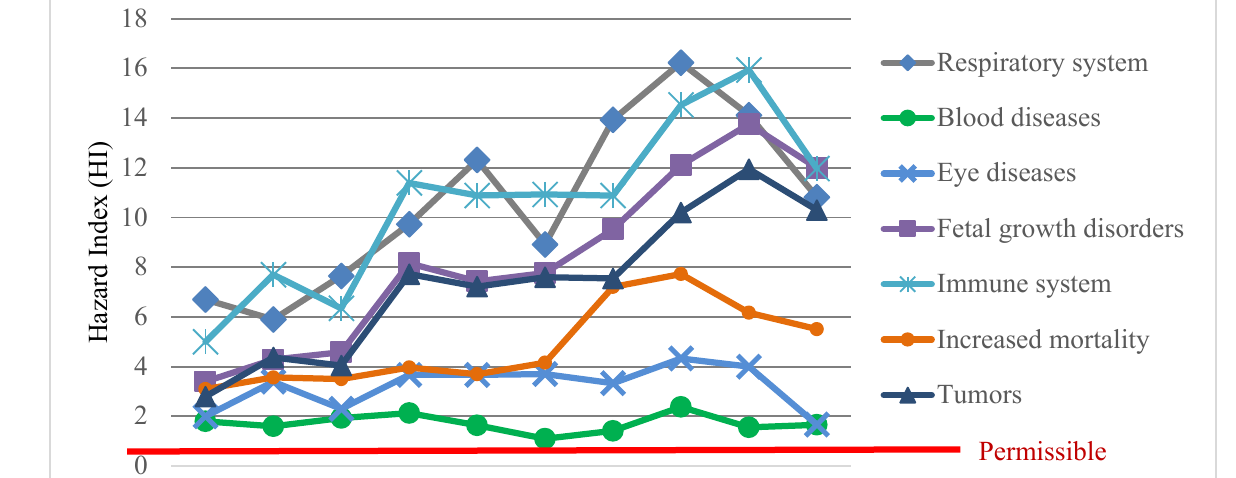
basis of data on the average annual concentrations of air pollutants measured at monitor- ing stations. In 2020, chronic inhalation exposure to pollutants could cause disease in the population of Ulan-Ude: respiratory system (hazard index HI = 10.8, with the permissible value of 1), blood diseases (HI = 1.7), vision diseases (HI = 1.67), fetal growth disorders